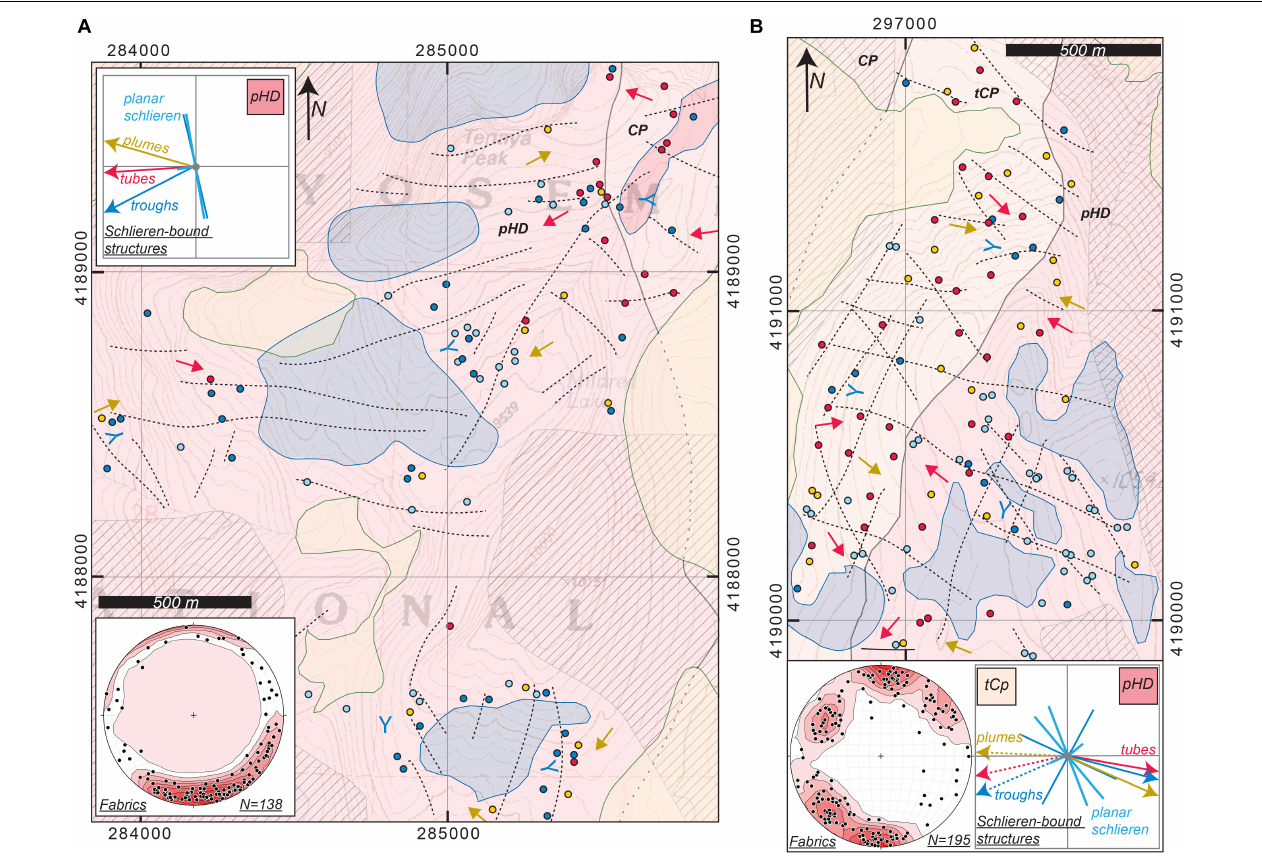
FIGURE 8 | Magmatic structures field data summary of the Tenaya Peak and Lyell Canyon areas. Bold lines mark major unit contacts. Hatching indicates unmapped areas. The trend of steeply dipping (70 ◦ –90 ◦ ) magmatic foliations is shown by dashed lines. Magmatic lineations are steeply plunging, regardless of the strike of the foliation. The locations of different schlieren-bound structures are shown by colored dots (see key in Figure 6 ). Y or arrow symbols are oriented in the direction of measured migration/younging. Inset box shows the domain-scale magmatic foliation summary on a stereonet, and a summary of average younging/migration orientations shown with arrows. pHD-Porphyritic Half Dome granodiorite; CP-Cathedral Peak granodiorite; tCP-Transitional Cathedral Peak granodiorite. (A) Tenaya Peak, SW quadrant (after Aldiss, 2017). (B) Lyell Canyon, SE quadrant (after McColl, 2017). Co-ordinate system used: UTM NAD27 zone